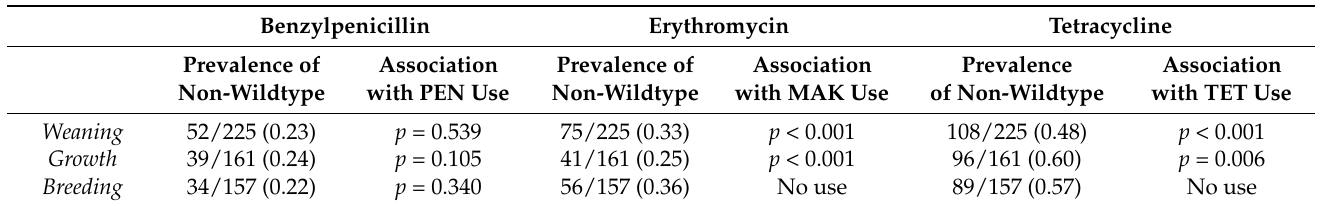
Table 2. Antibiotic non-wildtype among Staphylococcus delphini isolates from Danish mink from 2018–2019. Association between antibiotic non-wildtype isolates and short-term use of the respective antibiotic drug on farm just prior to sampling ( χ 2 -test